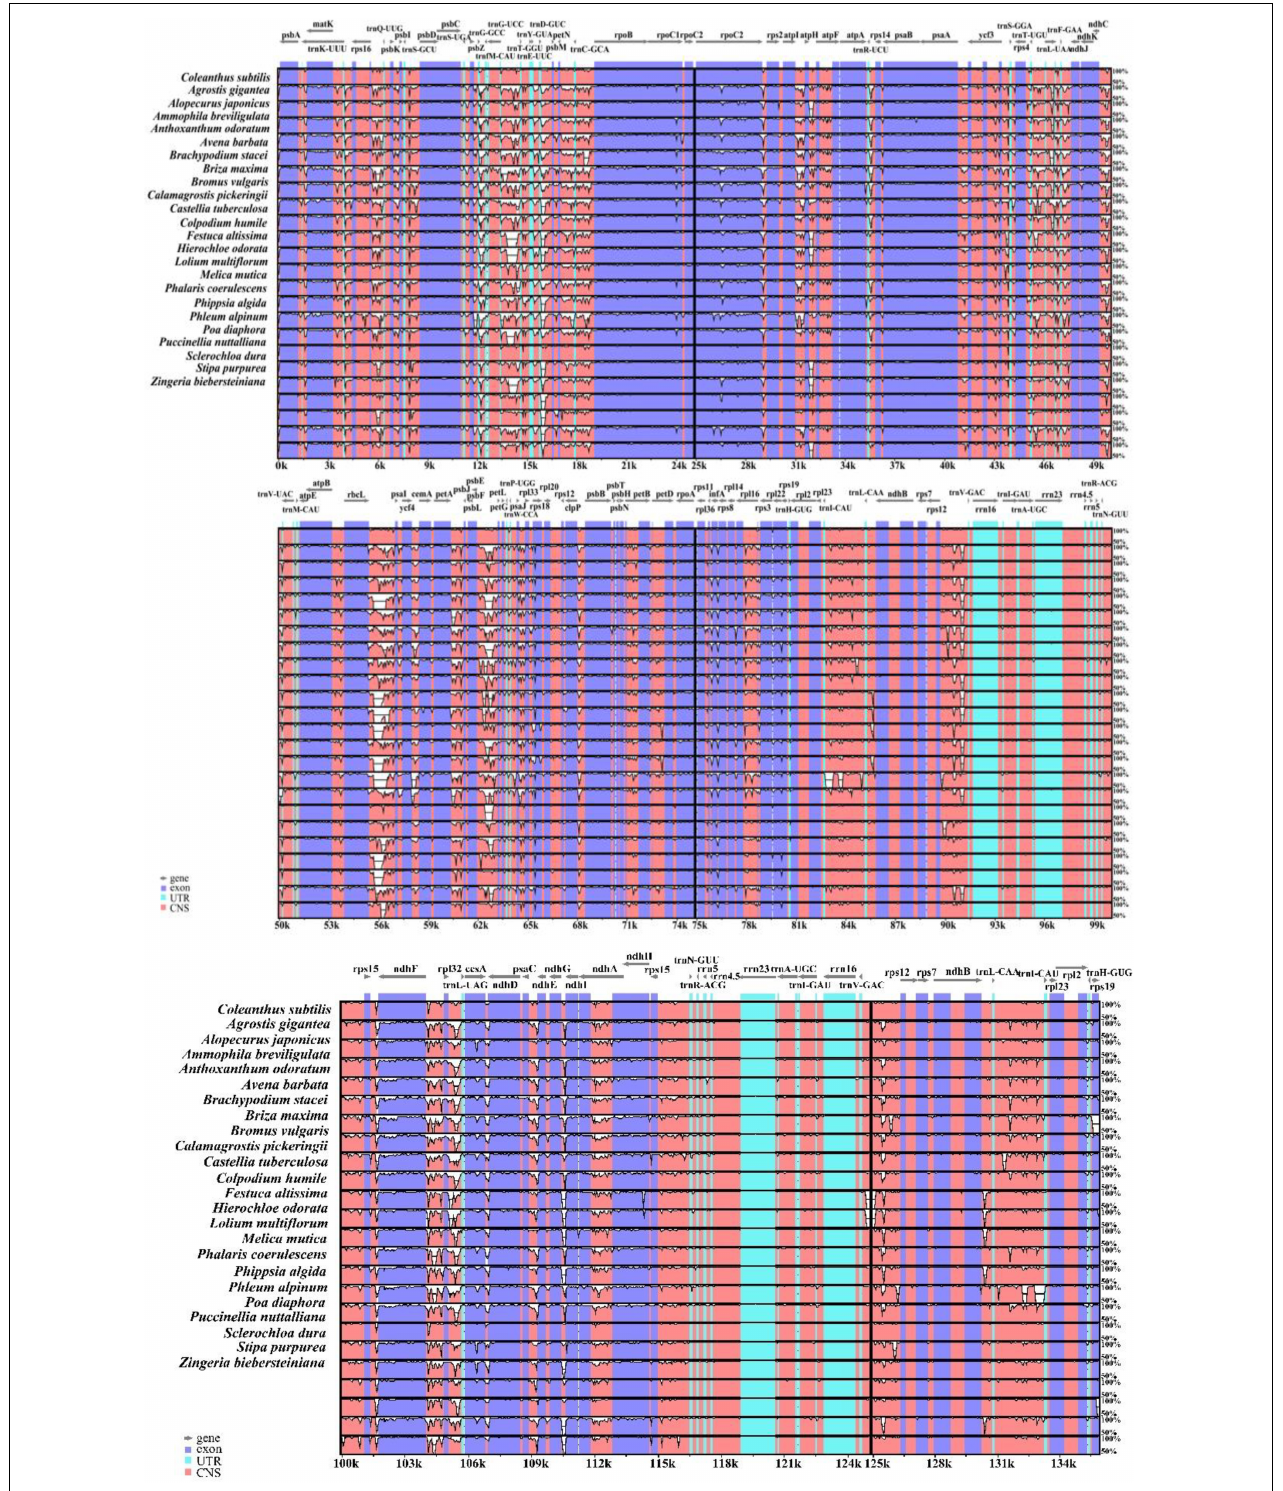
FIGURE 4 | The Shuffle-LAGAN alignment was used in mVISTA to compare the contiguity of the chloroplast genomes of 24 species, with C. subtilis as the reference. The vertical scale in the figure indicates the degree of identity between 50% and 100%, while the horizontal scale shows the sequence information of the chloroplast genomes. Gray lines indicate gene direction, order and